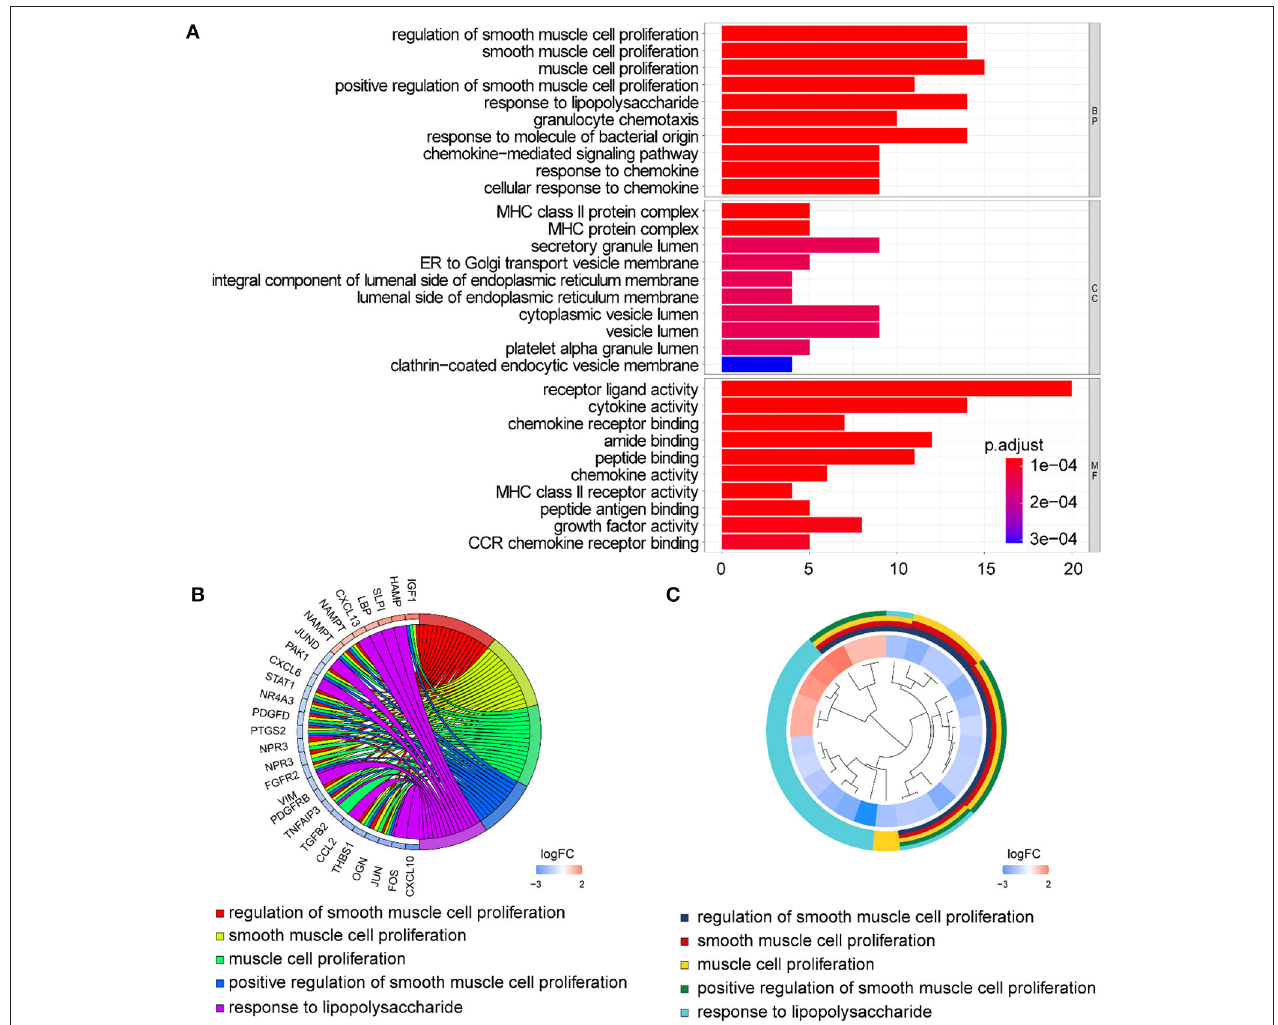
FIGURE 10 | GO analysis of the 75 DE-IGs between inflamed and fibrotic livers of BA. (A) The 10 most significantly enriched GO terms are displayed in the barplot. The length of the bar represents the number of genes enriched and the color represents the correlation. BP, biological process; CC, cellular component; MF, molecular function. (B) GO chord diagram of the DE-IGs. The outer circle represents different genes and GO terms. The color depth of the outer circle of genes represents the logFC indicating gene expression level. The internal colorful ribbon represents the different GO terms the genes enriched. (C) The GO cluster of the DE-IGs. The outer circle represents the GO terms for the genes enriched, and the inner circle represents the logFC of each gene, with the color depth corresponding to the gene expression